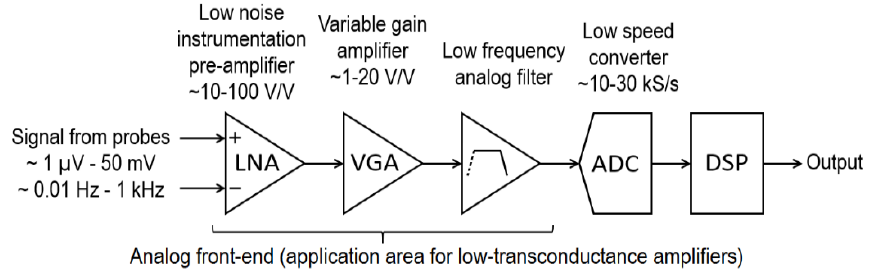
Figure 1. The main components of a microelectronic system processing low-frequency signals.